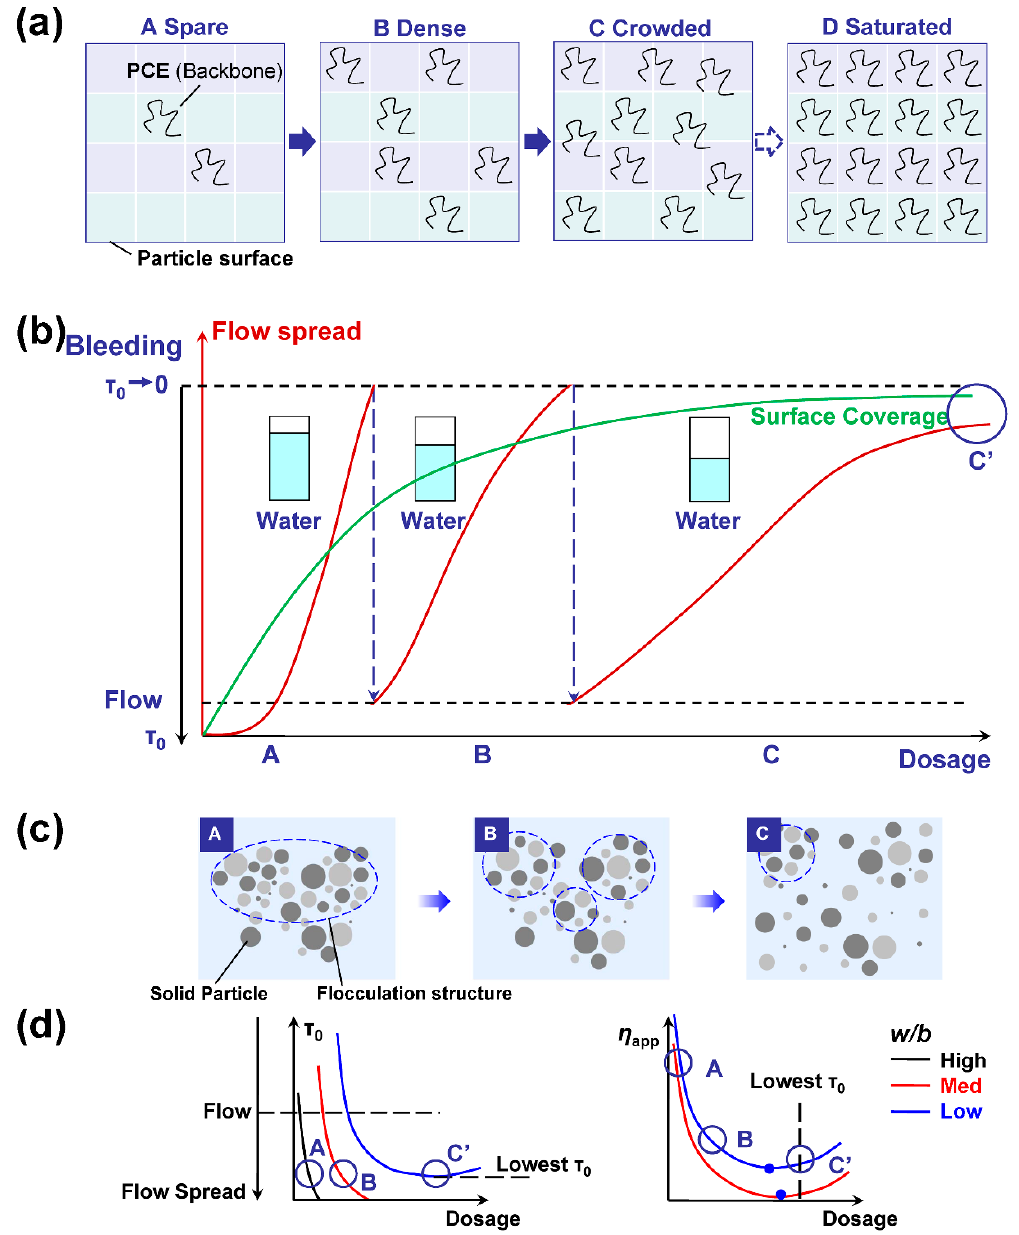
Figure 5. Effect of PCE dosage on the surface coverage ( a ), flow behavior ( b ), flocculation structure ( c ), yield stress (left in ( d )) and apparent viscosity (right in ( d )) of cement paste at varied w/b. A, B, C, and C’ in ( b – d ) indicate the same PCE dosages. The surface coverage of A, B, and C in ( b – d ) is in the range of A, B, and C in ( a ). C’ stands for full surface coverage (by experimental testing). ( a ) Each PCE backbone occupies a small grid on the particle surface without overlap (monolayer adsorption). From A to D, more and more PCE molecules adsorb on the surface. However, the PCE molecules are randomly distributed but not arranged in order on the surface in C. The surface saturation state D should be difficult to reach. ( b ) Flow spread of cement paste against PCE dosage at varied w/b. At C’, the flow spread reaches the maximal value. ( c ) The flocculation degree becomes lower and lower with the increase in PCE dosage (surface coverage). Due to preferential adsorption of PCE on different mineral phases, low surface coverage on a negatively charged surface should be a common condition, especially for PCE of extremely low adsorption affinity. The flocculation degree at C’ can still be reduced by using another type of PCE. ( d ) At least two stages evolution of yield stress (de- crease to plateau) against dosage can be observed within the dosage range of common application. Few reports have demonstrated the increase in yield stress at extremely high PCE dosages for com- mon PCE samples, due to depletion [59] or bridging [60,61]. Three stages of evolution of apparent viscosity can be observed (decrease, plateau, and increase).